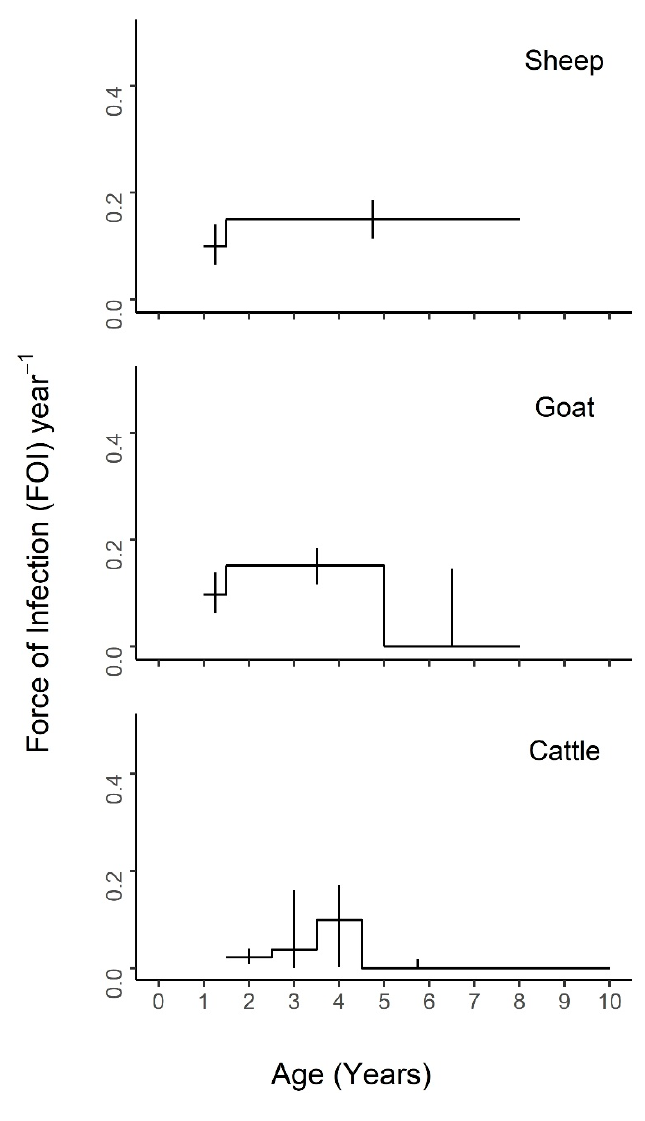
Figure 4. Age-varying force of infection models are a better fit than constant models for PPRV transmission by species. Age-specific force of infection estimates and profile confidence intervals from the best fit models for each species from a piece-wise catalytic model.